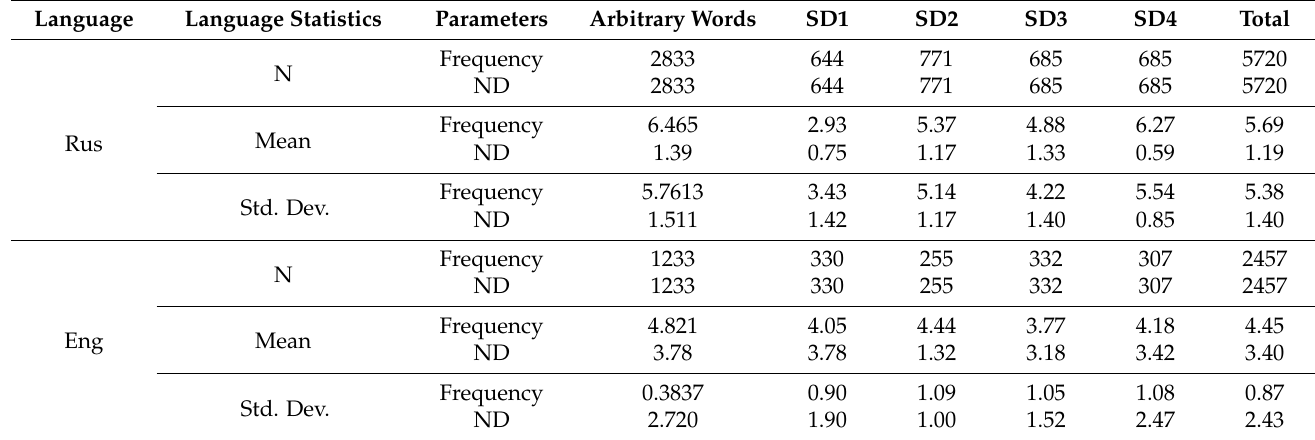
Table 7. Descriptive statistics for covariates Frequency and Neighborhood density